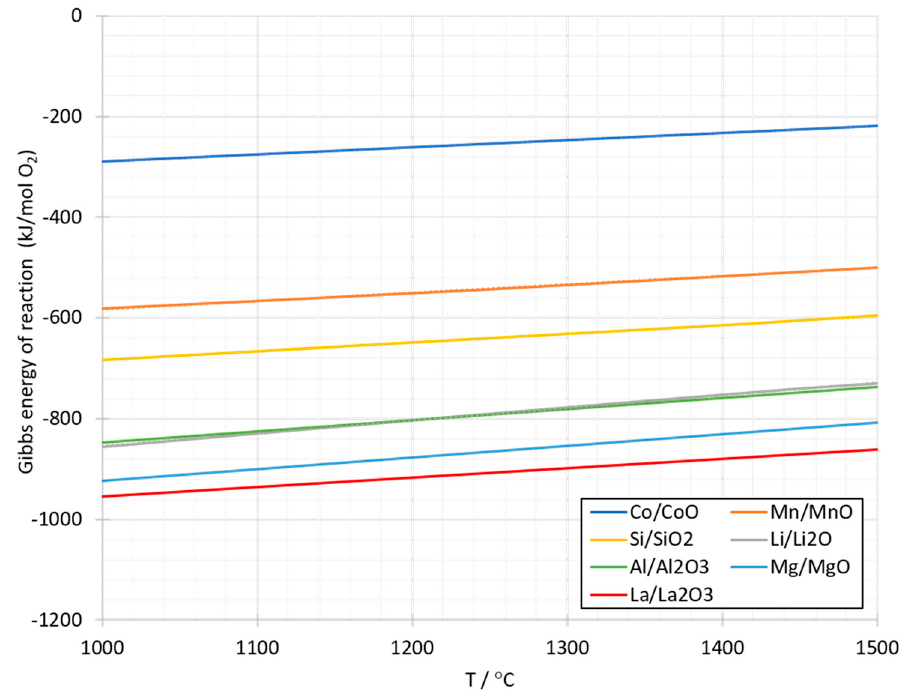
Figure A1. An Ellingham diagram for Li 2 O, CoO, MnO, La 2 O 3 , Al 2 O 3 , MgO, and SiO 2 . Calculated with HSC Chemistry 6.12.